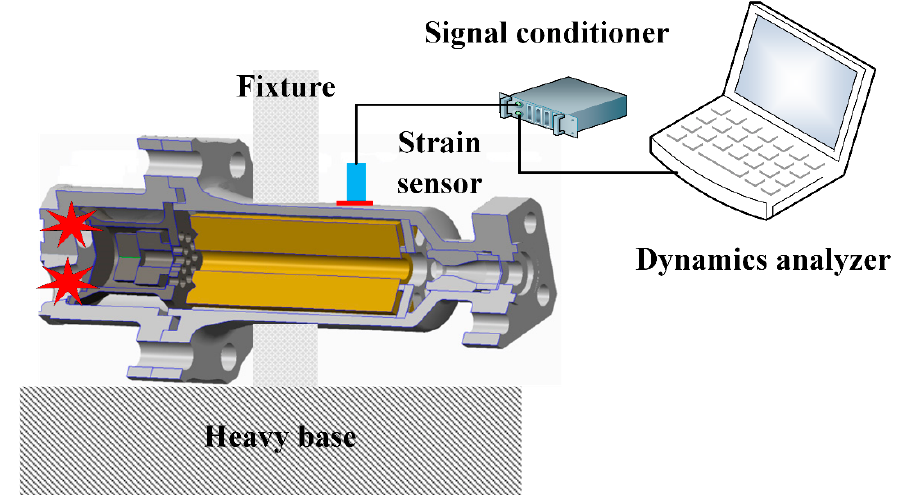
Figure 4. Configuration of the experiment.